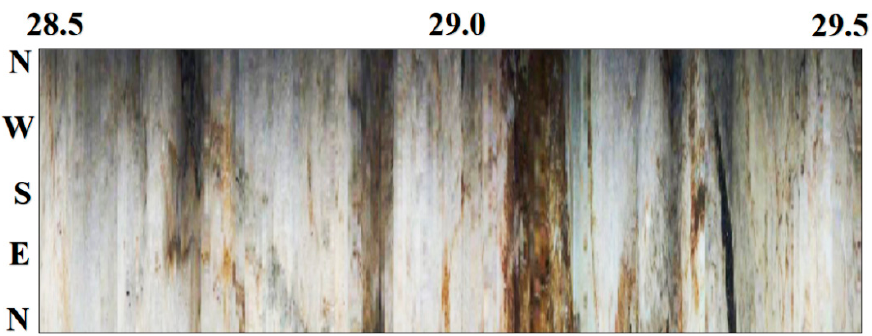
Figure 9. Rock wall expansion image.